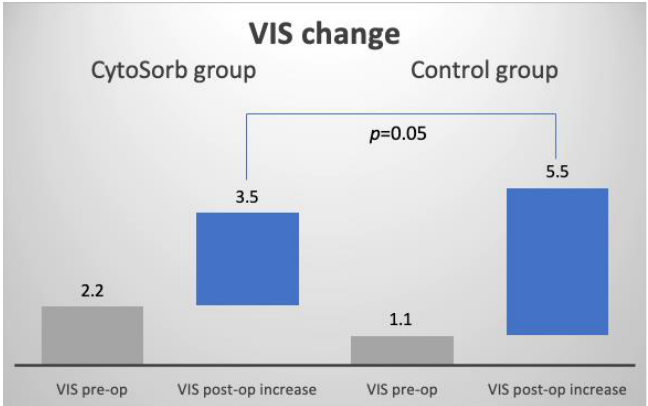
Figure 2. Comparison of difference in VIS change: CytoSorb ® + 3.5 vs. control + 5.5, p = 0.05. Table 2. Vasoactive-inotropic score change.